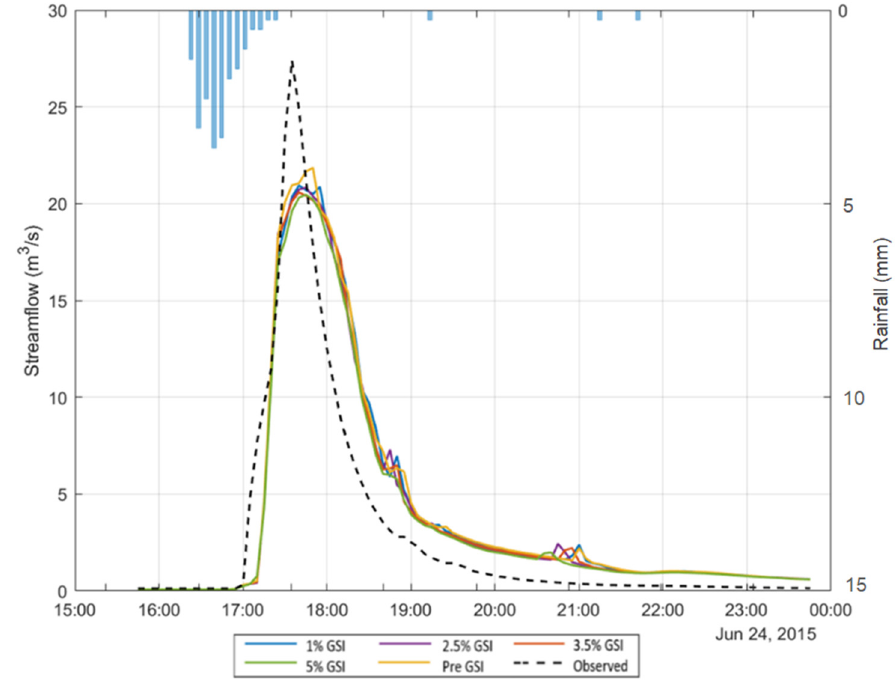
Figure 4. Observed, calibrated (pre-GSI), and modeled GSI scenario (1%, 2.5%, 3.5%, and 5%) streamflow at study area outfall with precipitation observed at USGS gage 393947104555101 at 5 min time intervals.